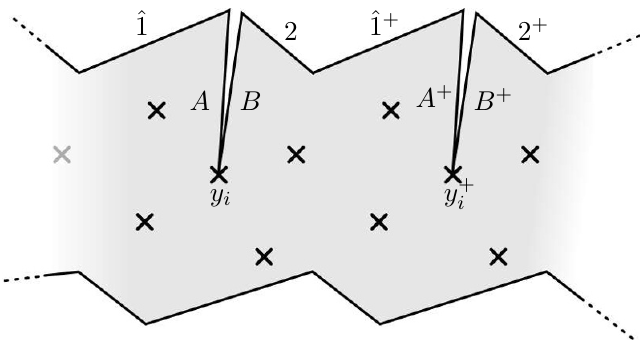
Figure 15 . Single-cut factorization poles for the cylinder loop integrand W 2 ; 2; L ( l ). The cusp ^ x 1 becomes null separated from a chiral Lagrangian insertion point y i . The periodic images of y i are likewise null separated from images of ^ x 1 , ( y [ a ]